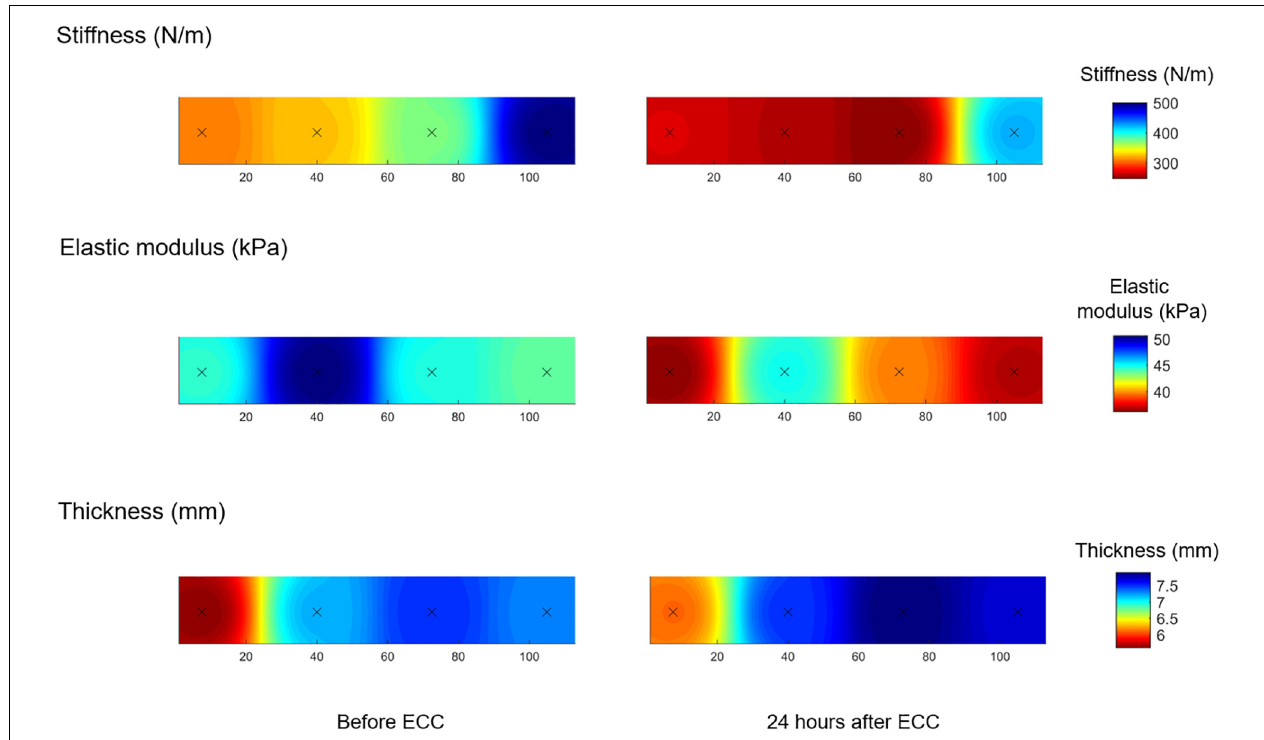
FIGURE 3 | Average topographical maps of the upper trapezius muscle dynamic stiffness measured by myotonometry, elastic modulus measured by shear-wave elastography and muscle thickness measured by ultrasonography before and 24 h after eccentric exercise (ECC), N =